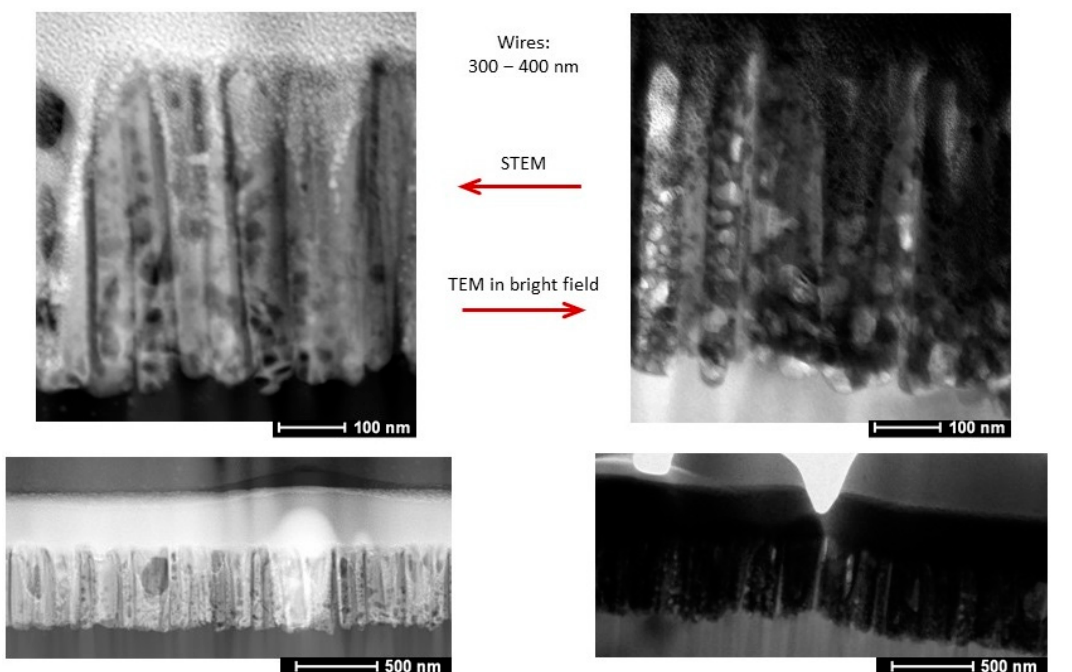
Figure 11. STEM image ( left column), and TEM BF image ( right column) of the silicon wafer with wires etched by MAE for 20 s with a perovskite layer obtained in a two-step deposition process.